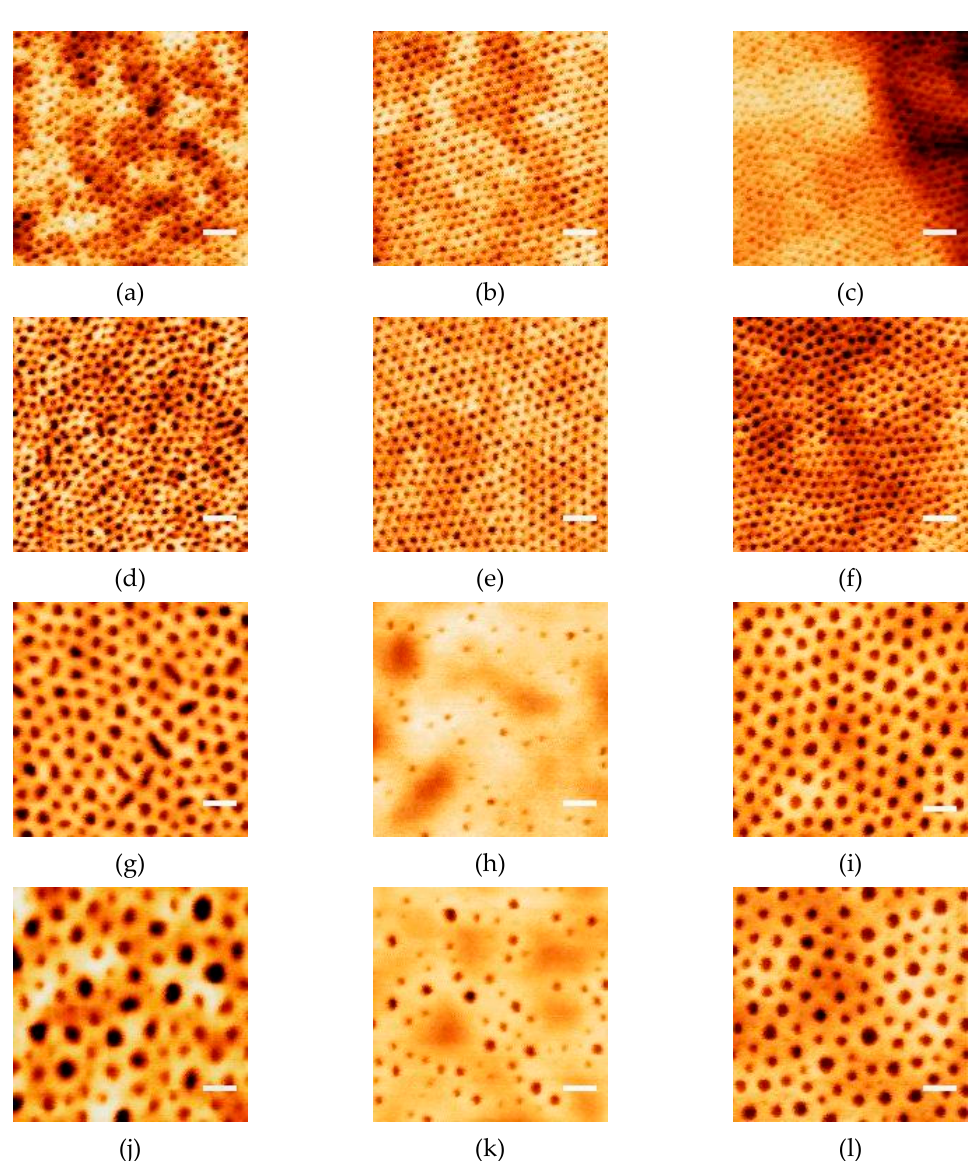
Figure 2. Atomic force microscopy (AFM) images of BCP templates from ( a ), ( b) and (c ) SEO-26k; ( d ), ( e ) and ( f ) SEO-49k; ( g ), ( h ) and ( i ) SEO-89k; ( j ), ( k) and ( l ) SEO-136k. Columns 1, 2 and 3 list the film morphology before solvent vapor annealing (SVA), after SVA in toluene at 50 °C for 2 h, and after SVA in a toluene + water mixed vapor at 50 °C for 1 h, respectively. The scale bars are 100 nm.